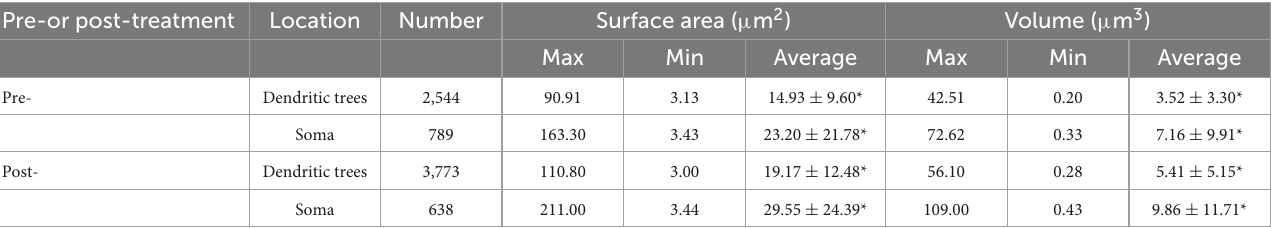
TABLE 2 Analysis of mitochondrial meshes in different subcellular units before or after simulated long-term pilot flight within PCs in PCs-Mito-GFP mice. Pre-or